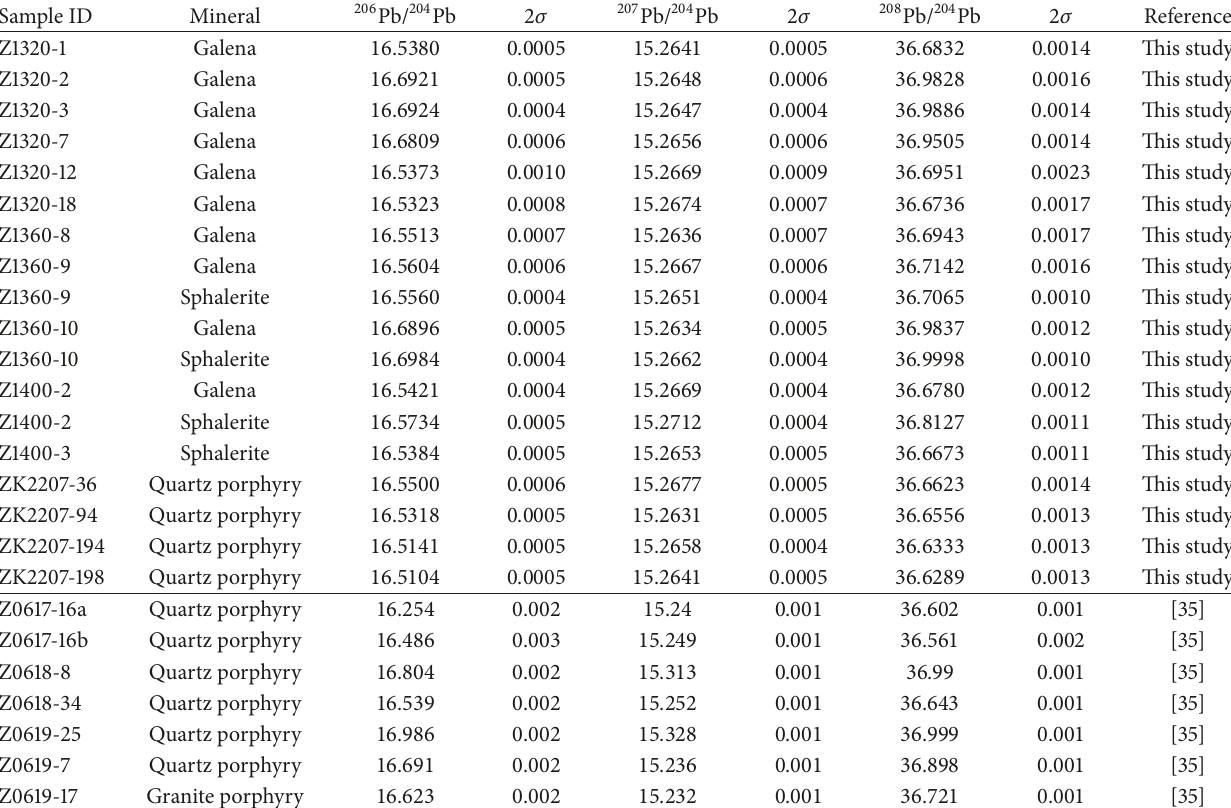
Table 4: Lead isotope data of sulfides and rocks from the Zhijiadi Ag-Pb-Zn deposit.